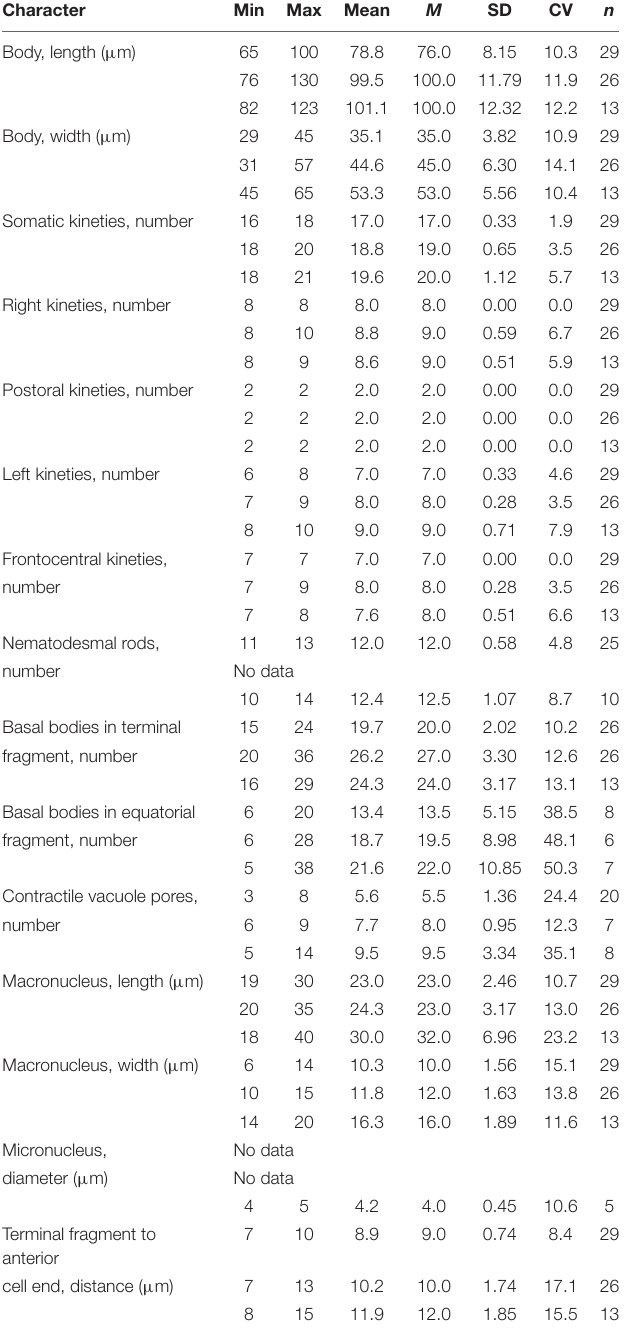
TABLE 3 | Morphometric data of Trithigmostoma cucullulus from Qingdao (upper rows), Zhanjiang (middle rows), and Shenzhen (lower rows) populations.